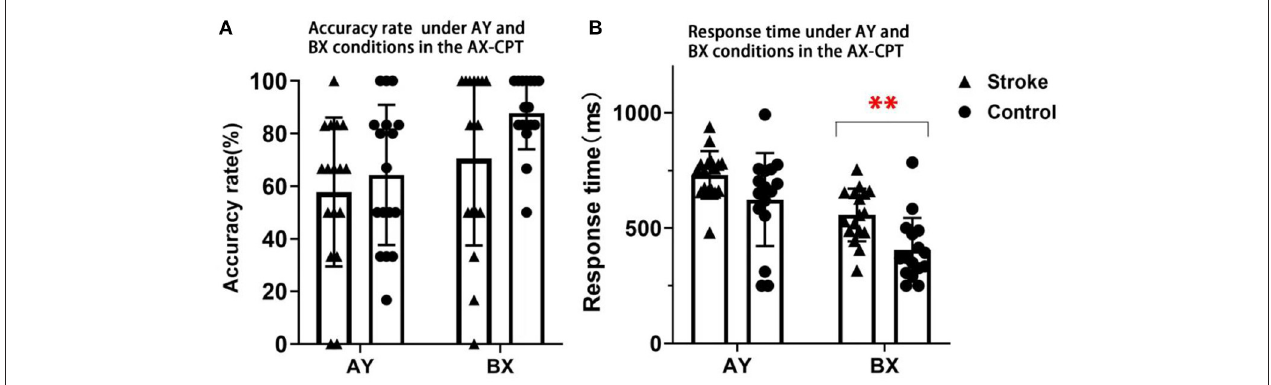
FIGURE 3 | The accuracy rates and response time in AY and BX conditions of stroke and control participants in the AX-CPT. (A) Presents the results of accuracy rate. (B) Presents the results of response time. Triangles denote the single subject distribution of the stroke group. Dots denote the single subject distribution of the control group. Error bars denote + /– SD. ** Denotes p <